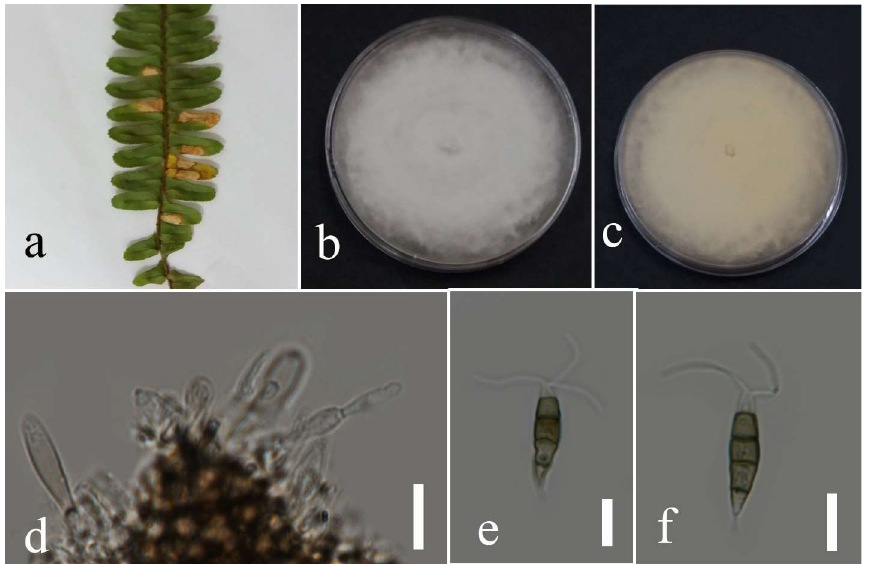
Figure 11. Morphology of Neopestalotiopsis psidii based on isolate MFLUCC 22 - 0141: ( a ) leaf spot in Nephrolepis cordifolia ; ( b , c ) upper and reverse views of the colony after seven days of growth on PDA at 28 °C; ( d ) conidiogenous cells; ( e , f ) conidia . Scale bars = 10 µm . Neopestalotiopsis saprophytica Maharachch . , K . D . Hyde & Crous, 2014. Facesoffungi number: FoF 13405; Figure 12.